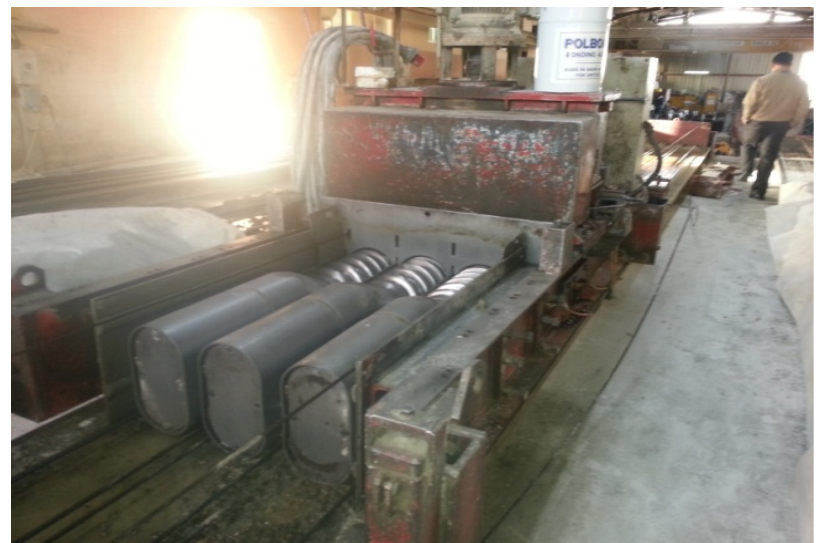
Figure 2. An extruding machine for manufacturing